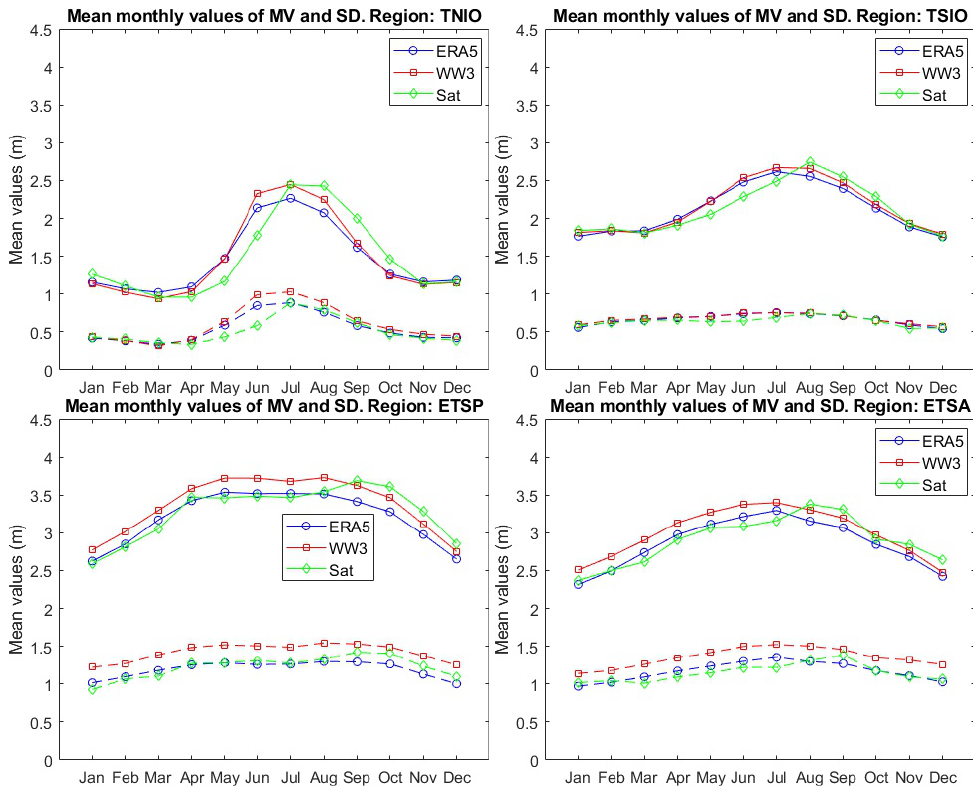
Figure 2. Mean monthly values for the northern extratropical zone (ETNP, ETNA), the tropical zone (TENP, TNAO, TNIO, TSIO) and the southern extratropical zone (ETSP, ETSA); see also Figure 1 (continuous: mean value, dashed: standard deviation).